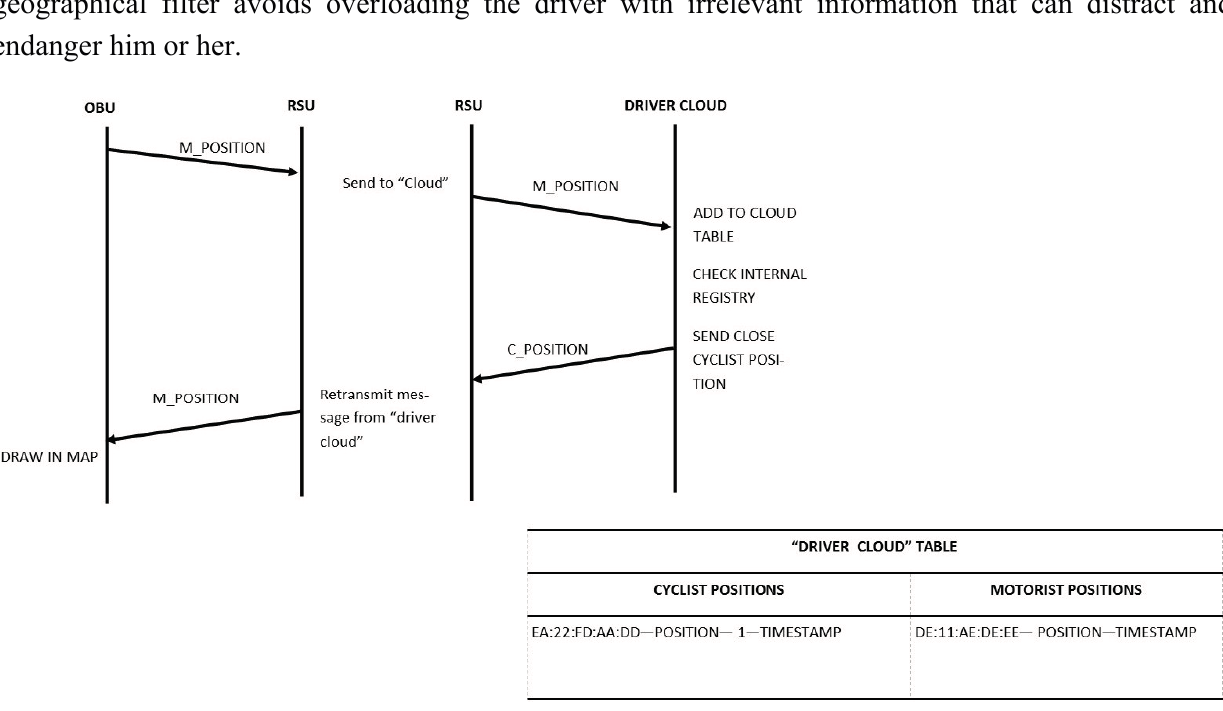
Figure 8. Communication protocol between OBU, RSU, and the Drivers